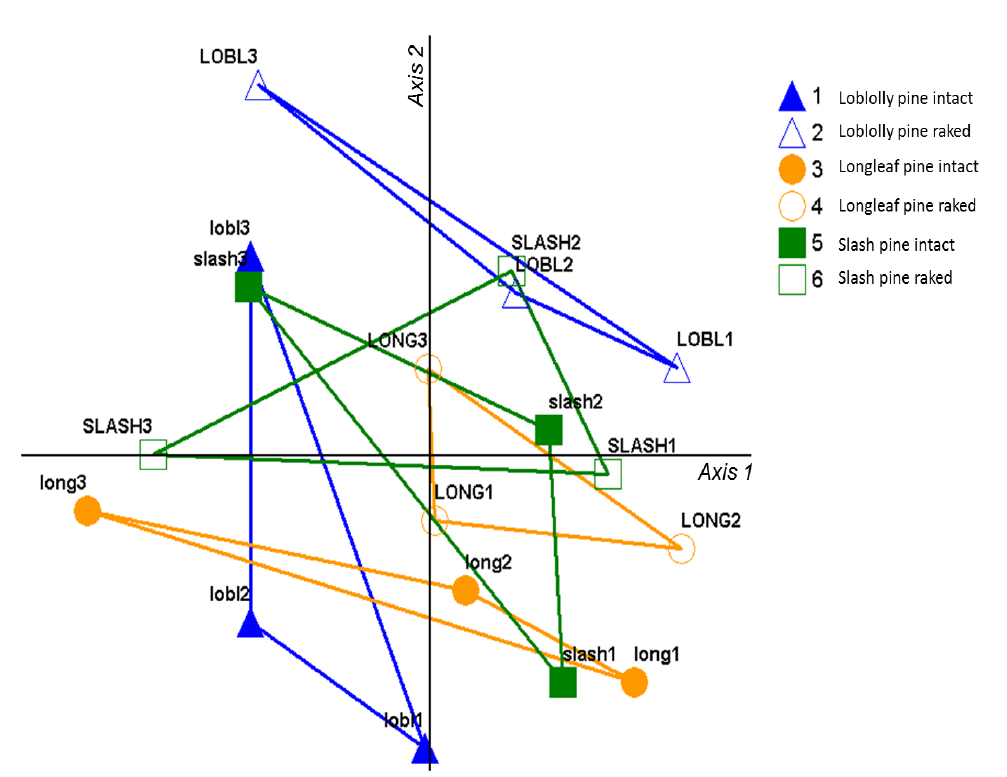
Figure 11. Non-parametric multidimensional scaling (NMS) biplot showing the abundances of the 14 dominant orders of arthropods collected during three years of seasonal pitfall trapping in pine plantations in North Florida; each point represents the community composition averaged across three replicate plots sampled four times each year. Points are labeled according to timber type (loblolly—―lobl‖, longleaf—―long‖, slash—―slash‖), year of data collection (2008—―1‖, 2009—―2‖, 2010—―3‖), and whether or not the raking treatment was imposed (intact stands appear in lower case, raked stands in upper